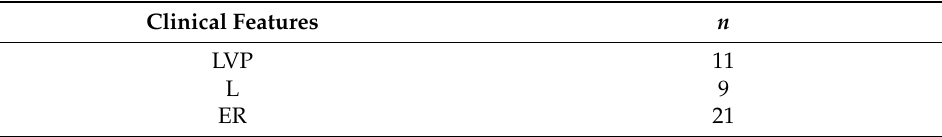
Table 3. Clinical appearance of biopsied lesions ( n =